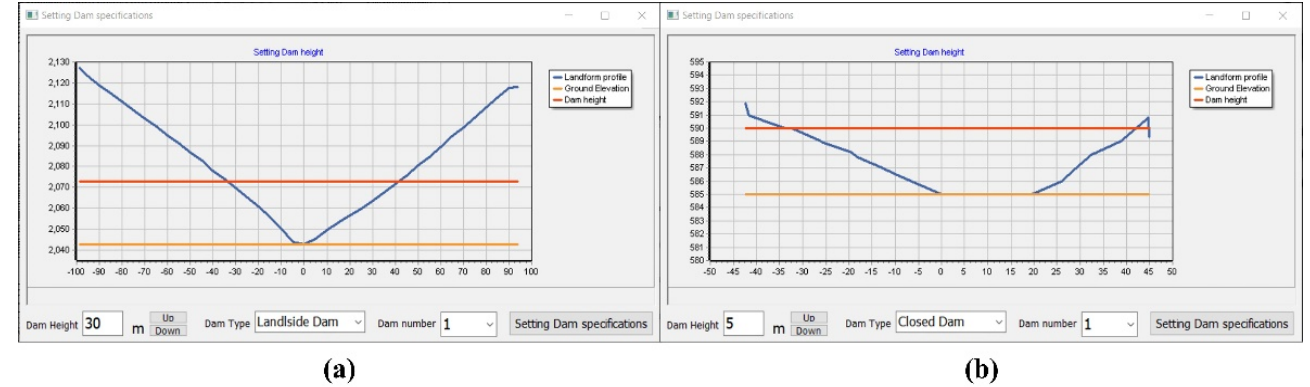
Figure 12. The setup of dams: ( a ) The landslide dam with a height of 30.0 m; ( b ) the closed dam with a height of 5.0 m.